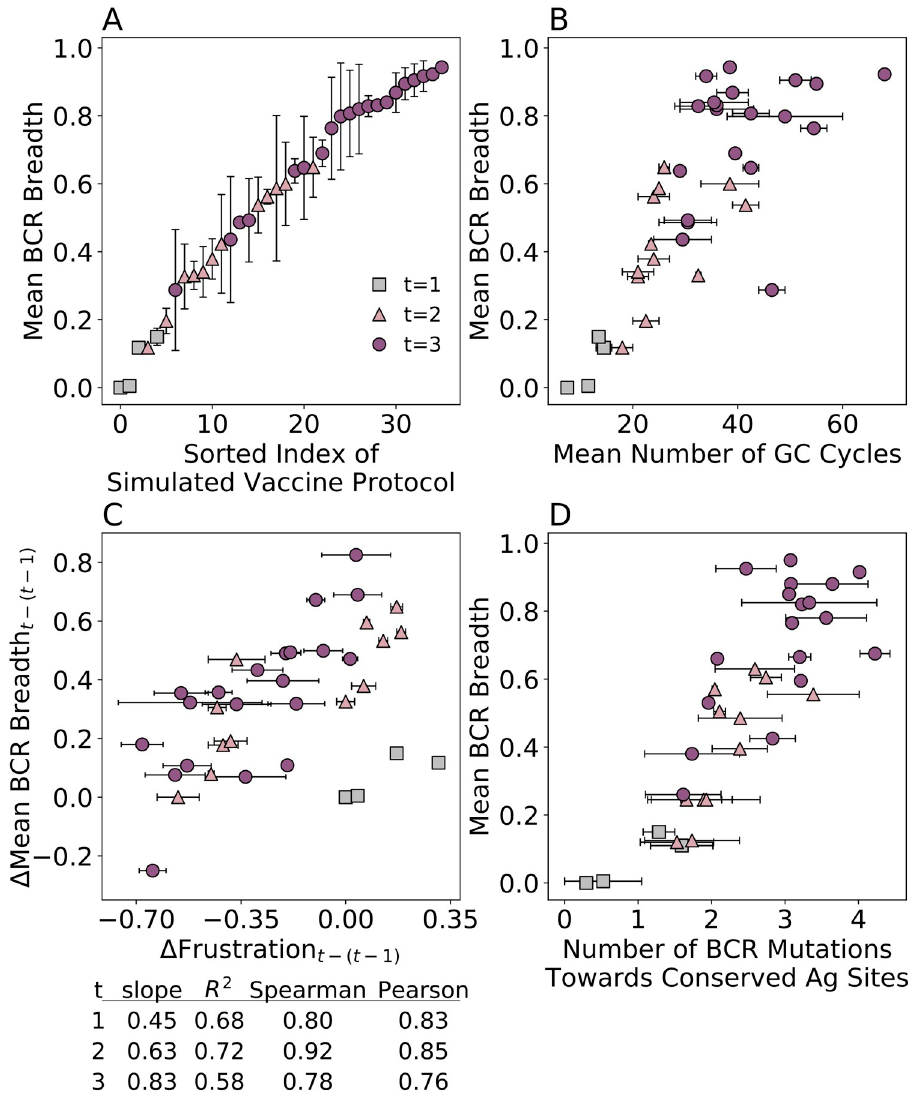
Fig 2. Results from AM simulations. (A) mean BCR breadth of vaccination protocols with t = 1, 2, and 3 single-Ag sequential immunizations, (B) mean BCR breadth vs. mean number of GC cycles, (C) changes in mean BCR breadth vs. changes in frustration between current (t) and former (t-1) immunizations, and (D) mean BCR breadth vs. mean number of mutations towards conserved Ag residues. In (C), linear fits were used to calculate the R 2 values presented in the table below the graph. Error bars represent the standard deviation of two independent simulations of each vaccination protocol (except for the KR-KR-KR and HQ-EU-WT protocols, for which only one successful trial could be obtained), consisting of between one and three immunizations/GC reactions (error bars for mean BCR breadth are only shown in (A) for clarity).